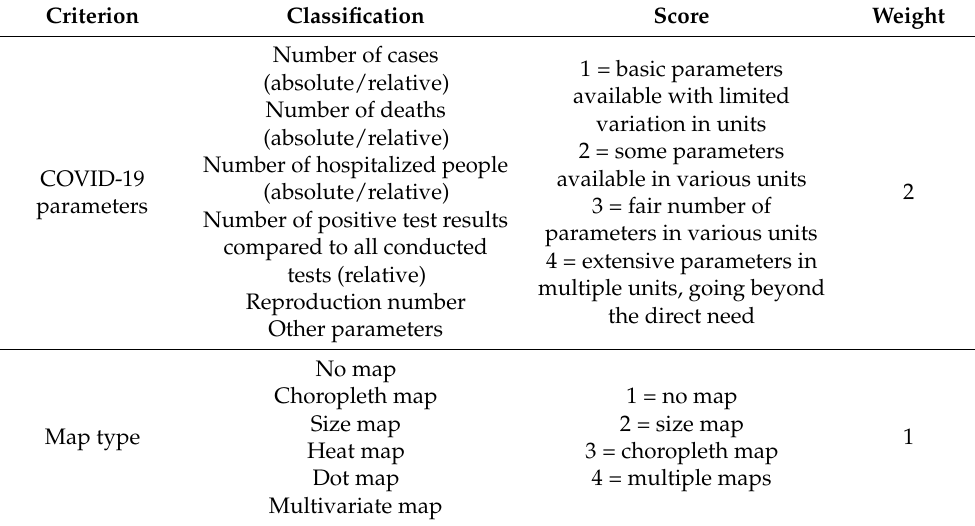
Table 2. Evaluation matrix for evaluation of